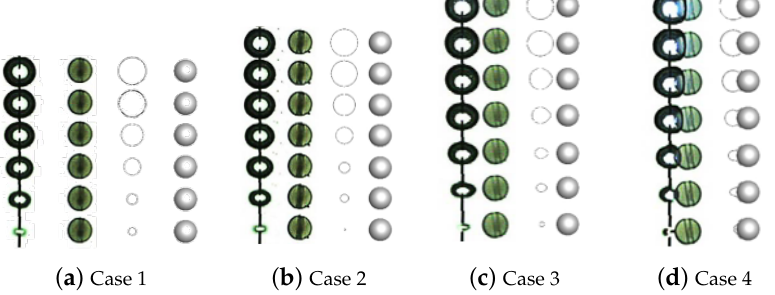
Figure 5. The comparisons of profiles of collapsing bubbles under the influence of static particles from experimental (left) and numerical (right)